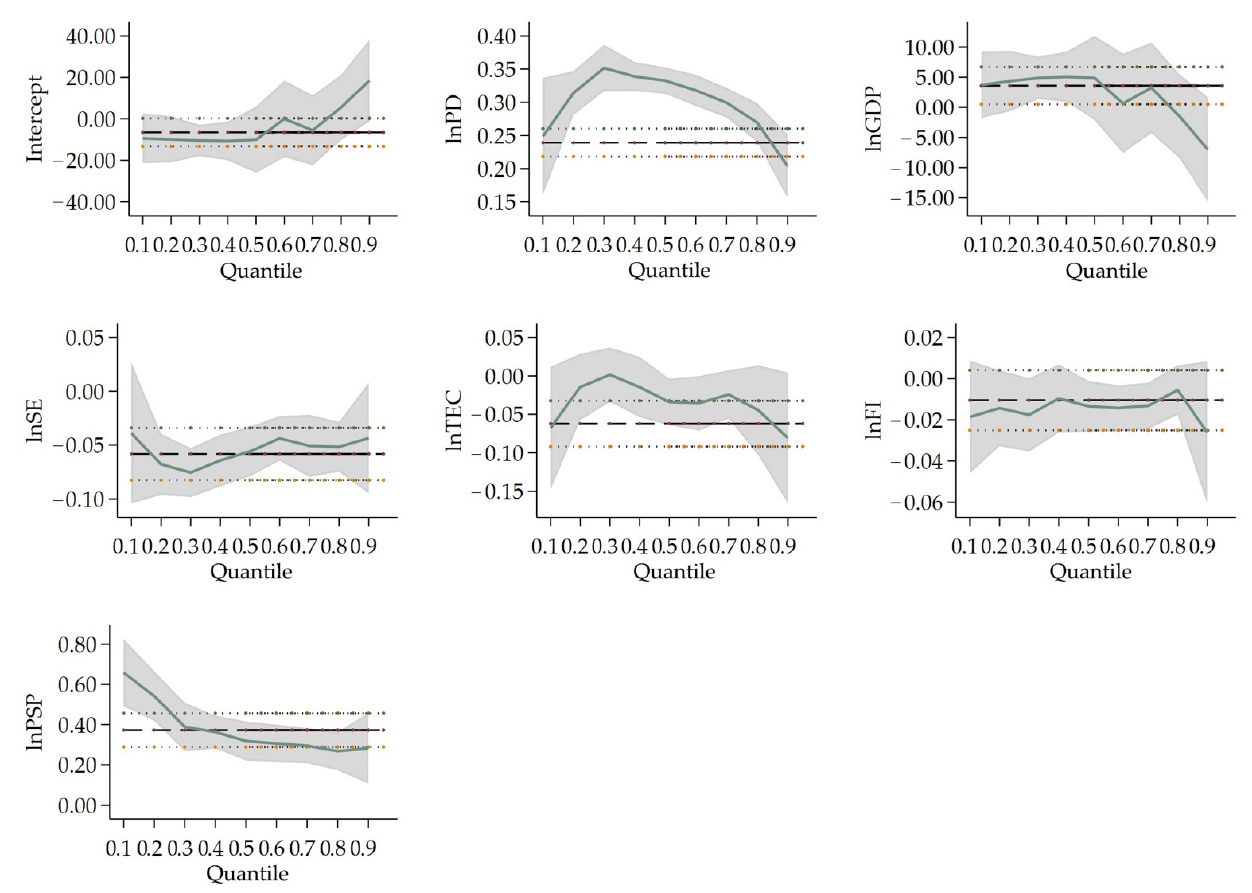
Figure 4. Change in variables’ coefficients in Type III cities’ quantile regression. Notes: the labels of all lines, the horizontal and vertical axis are the same as above.